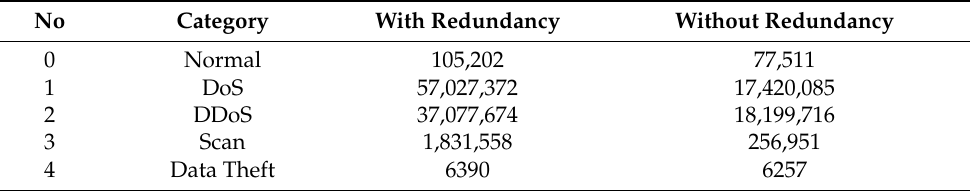
Table 2. BoT-IoT dataset instances.